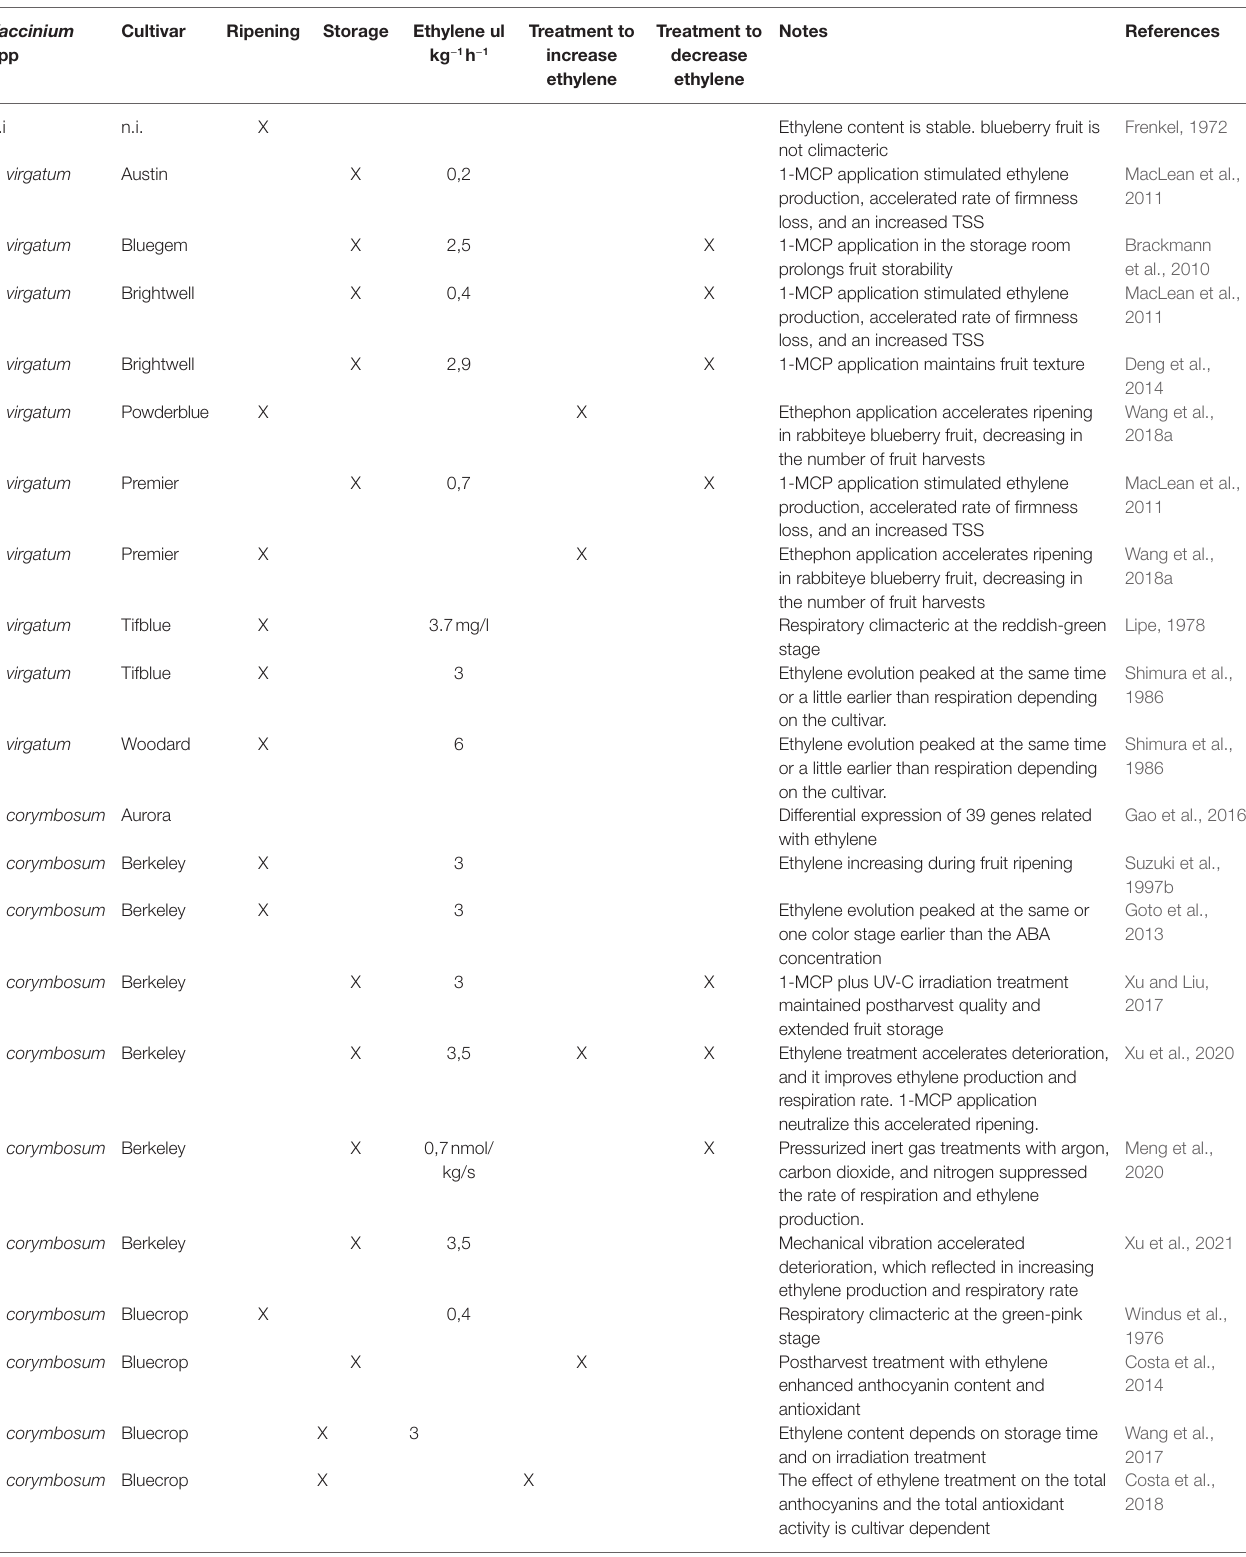
TABLE 1 | Bibliographic research about published studies related to ethylene production and sensitivity of Vaccinium accessions. Vaccinium